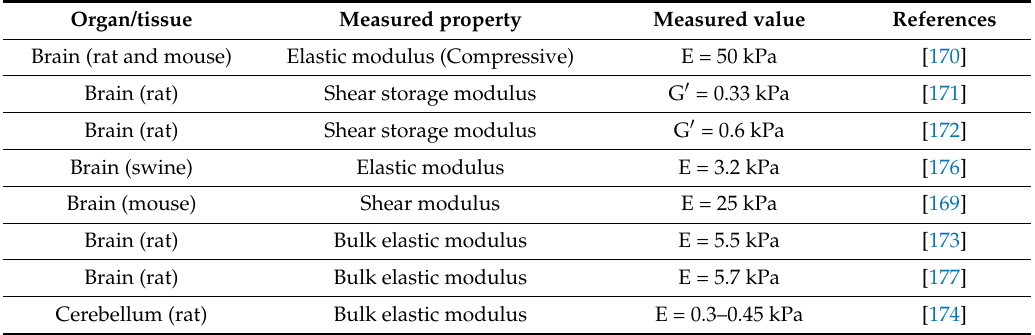
Table 1. Mechanical properties of brain tissue and hydrogel polymers used for cell encapsulation in neurorestaurative therapies